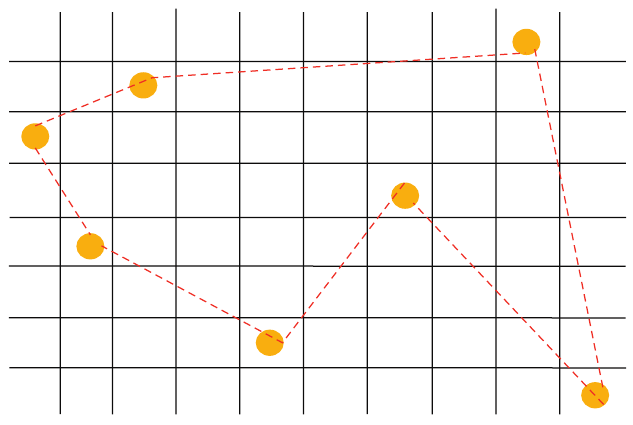
Figure 13: Latin hypercube